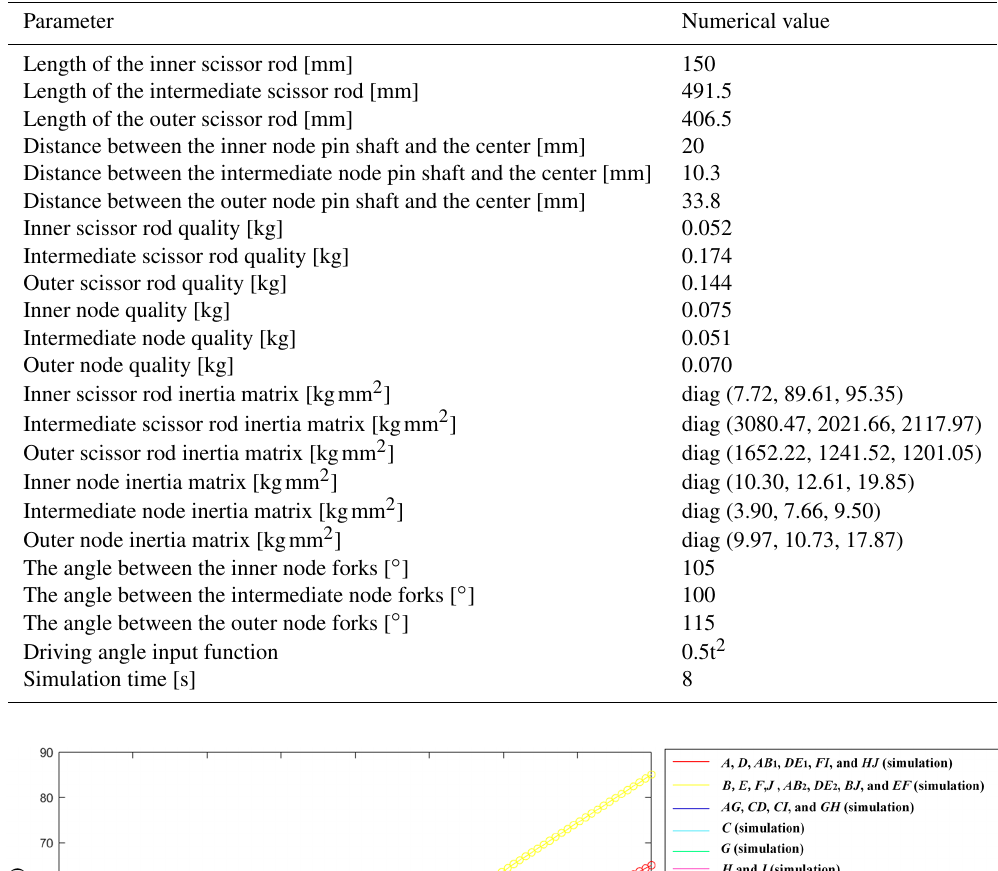
Table 1. Mechanism and physical parameter values.